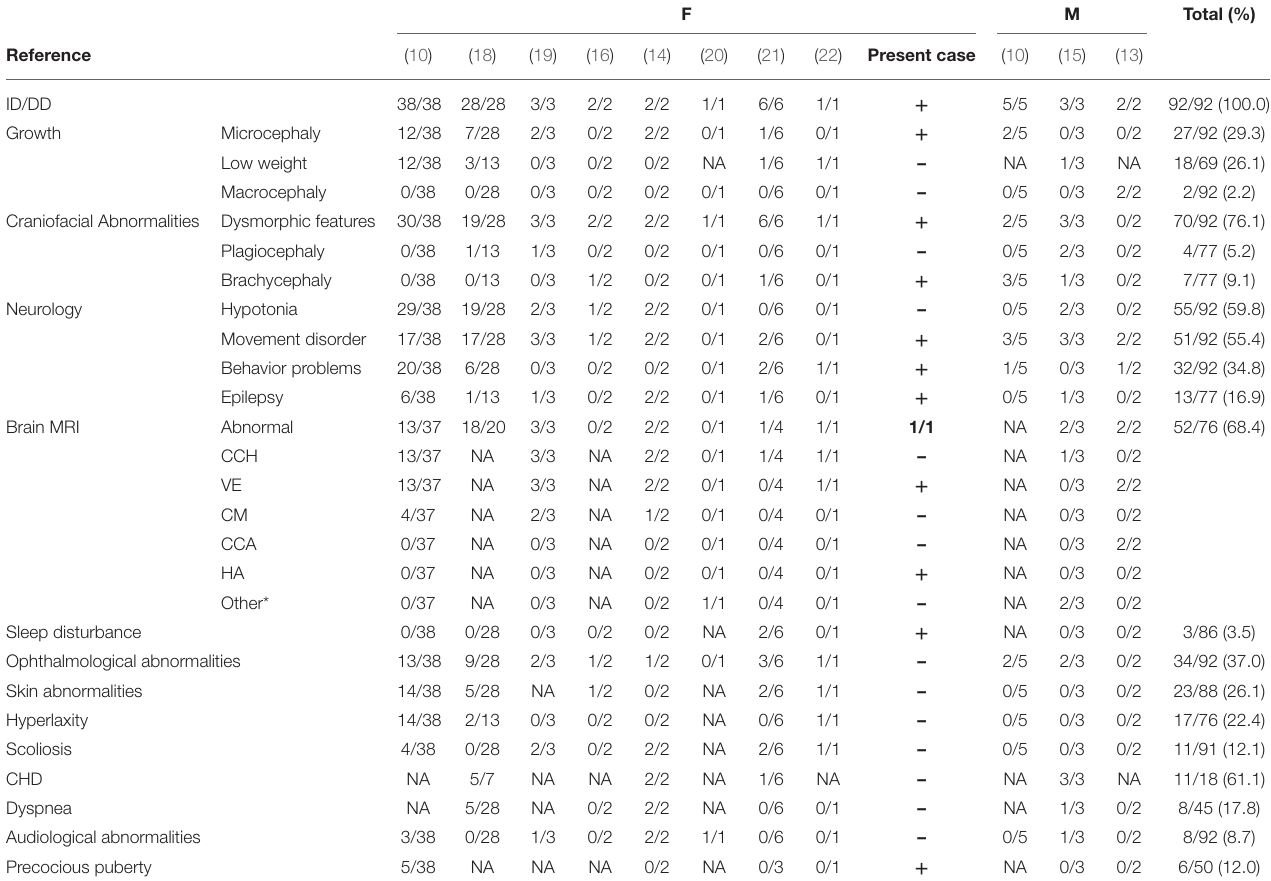
TABLE 1 | Clinical features of affected females and males with DDX3X variants.